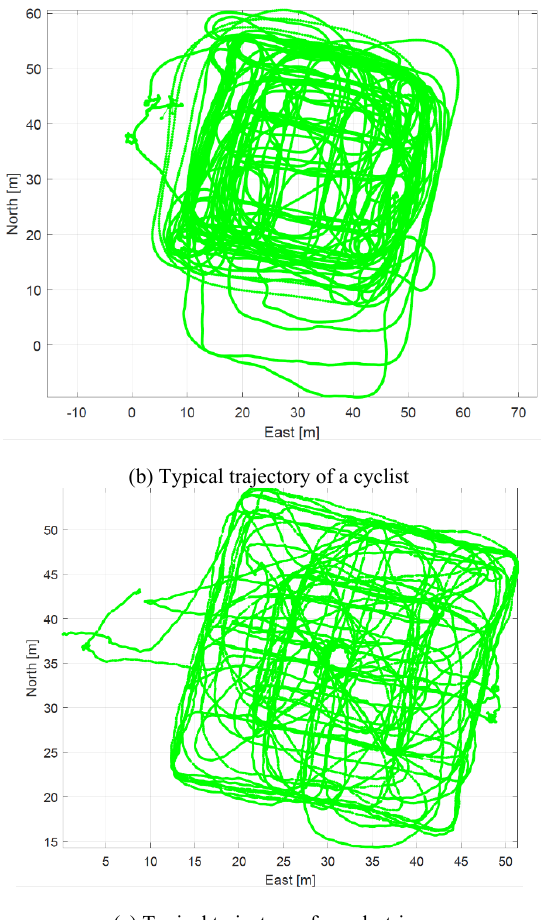
Figure 5 . Typical platform trajectories from a test run